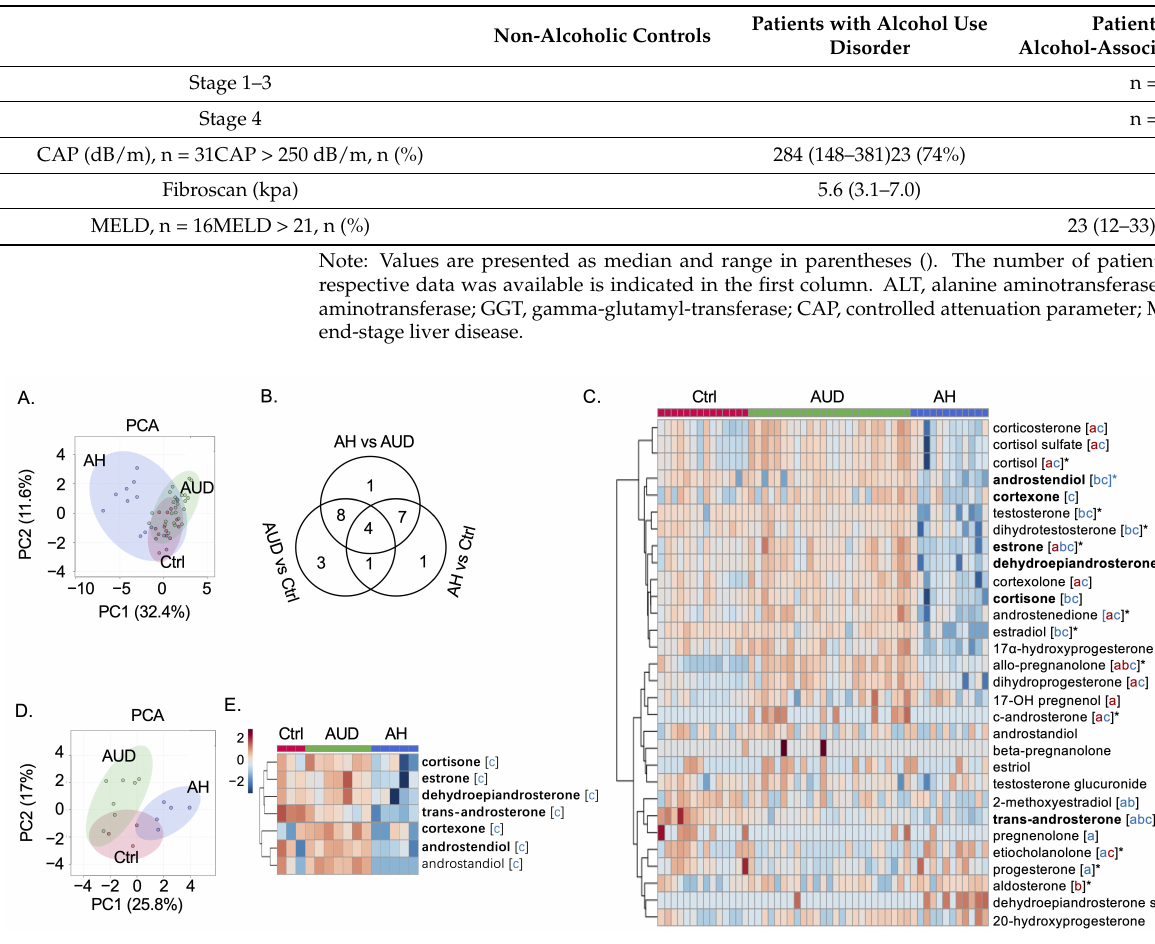
Figure 1. Serum steroid hormones in male and female patients. ( A ) Principal component analysis (PCA) of serum steroid hormones in male patients. ( B ) Venn diagram of significant (FDR < 0.05) serum steroid hormones in male patients. ( C ) Heatmap of 30 serum steroid hormones in male patients. * FDR < 0.05 in both serum and fecal samples; bold: FDR < 0.05 in both male and female patients. a: Patients with alcohol use disorder (AUD) vs. control subjects (Ctrl) FDR < 0.05, red: increase in patients with alcohol use disorder, blue: decrease in patients with alcohol use disorder; b: Patients with alcohol-associated hepatitis (AH) vs. control subjects FDR < 0.05, red: increase in patients with alcohol-associated hepatitis, blue: decrease in patients with alcohol-associated hepatitis; c: Patients with alcohol-associated hepatitis vs. patients with alcohol use disorder FDR < 0.05, red: increase in patients with alcohol-associated hepatitis, blue: decrease in patients with alcohol-associated hepatitis. ( D ) Principal component analysis of serum steroid hormones in female patients. ( E ) Heatmap of significant serum steroid hormones in female patients. c: Patients with alcohol-associated hepatitis vs. patients with alcohol use disorder FDR < 0.05, blue: decrease in patients with alcohol-associated hepatitis. Bold: FDR < 0.05 in both male and female